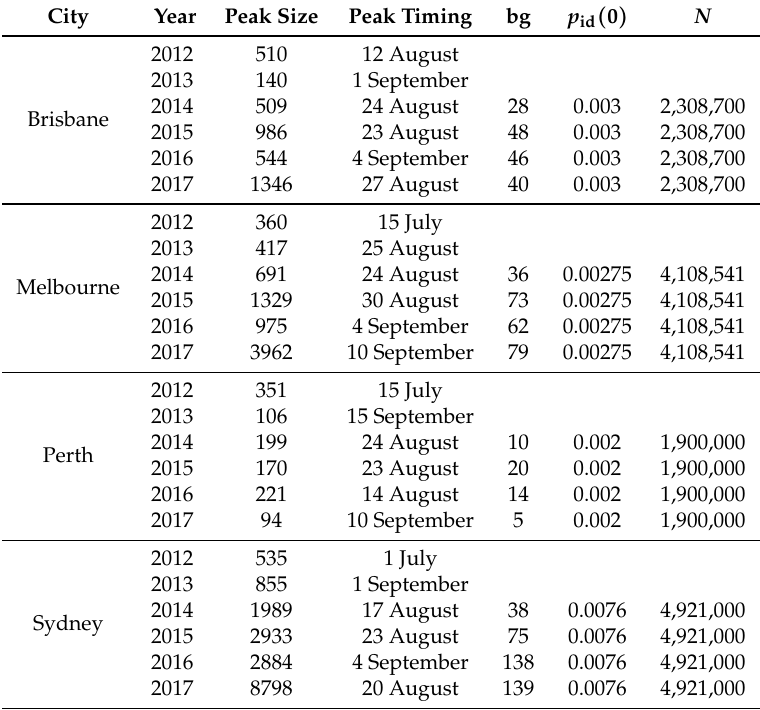
Table A2. The forecast parameter values, and the observed peak timing and size, for each of the capital cities. The observed peaks for 2012–2016 were used to construct a multivariate normal distribution for the peak timing and size in each city, in order to characterise the model priors for the 2017